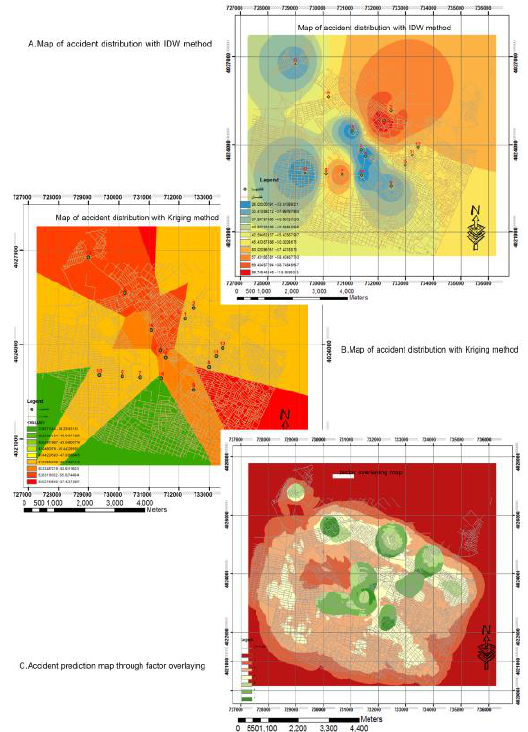
figure. 4 maps obtained from the operators of idw and kriging and factor overlaying to compare and evaluate the amounts obtained, it is necessary to standardize the results from overlaying by using the following function.